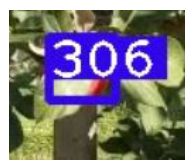
Figure 11. The apple does indeed become clearer in the following frame, allowing for detection to occur and the tracker to save and count the